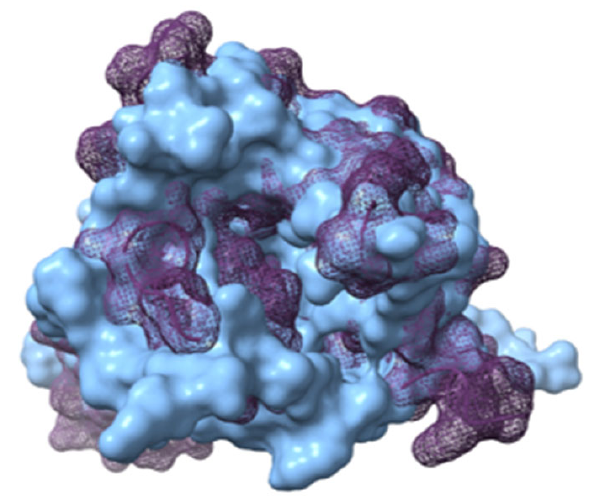
Figure 7. APLNR in both conformations superimposed. Active on purple mesh and inactive on blue surface.